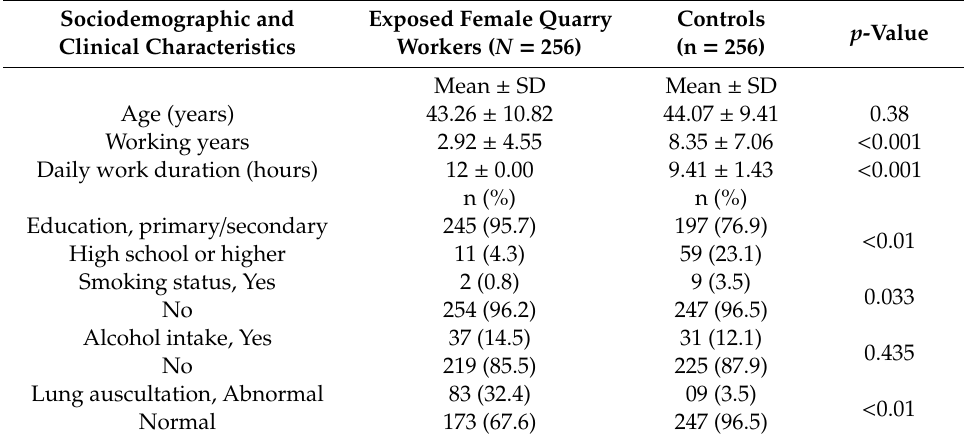
Table 1. Sociodemographic and clinical characteristics of participants.